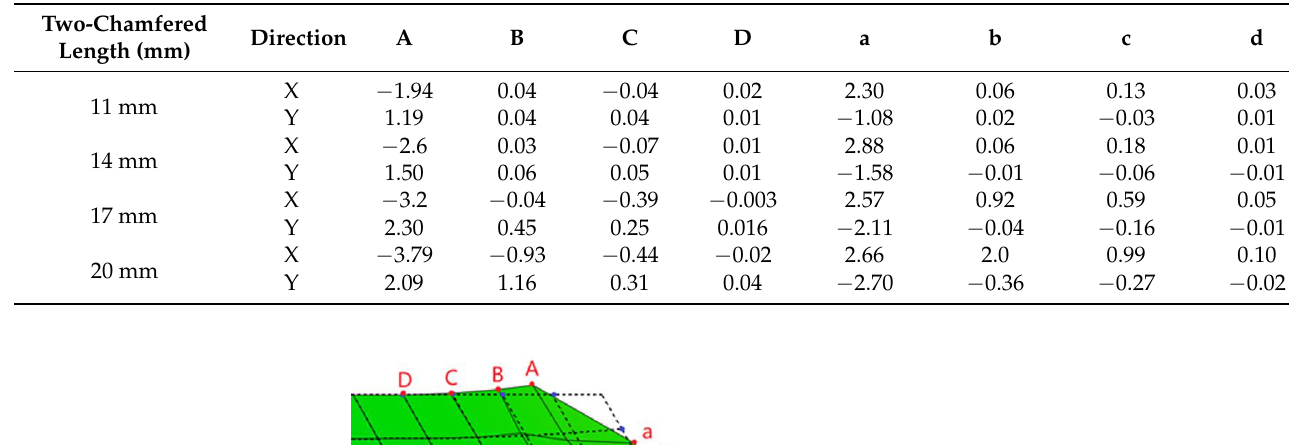
Table 5. Node deformation of different two-chamfered lengths under frontal rolling using a two- roller (mm).